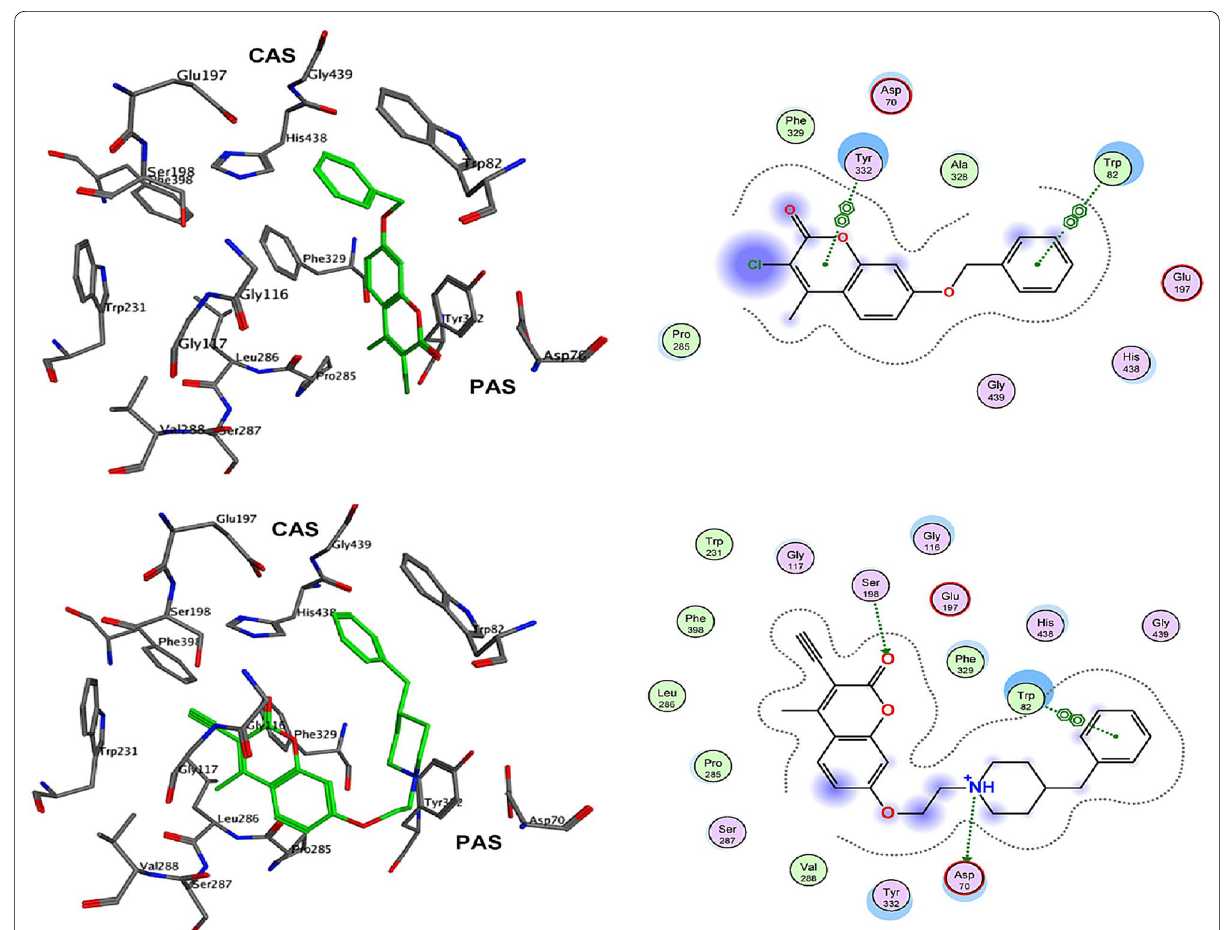
Fig. 90 Complex of compound C96b (top) and C96c (bottom) with the eqBuChE homology model (left) and the interaction maps (right)